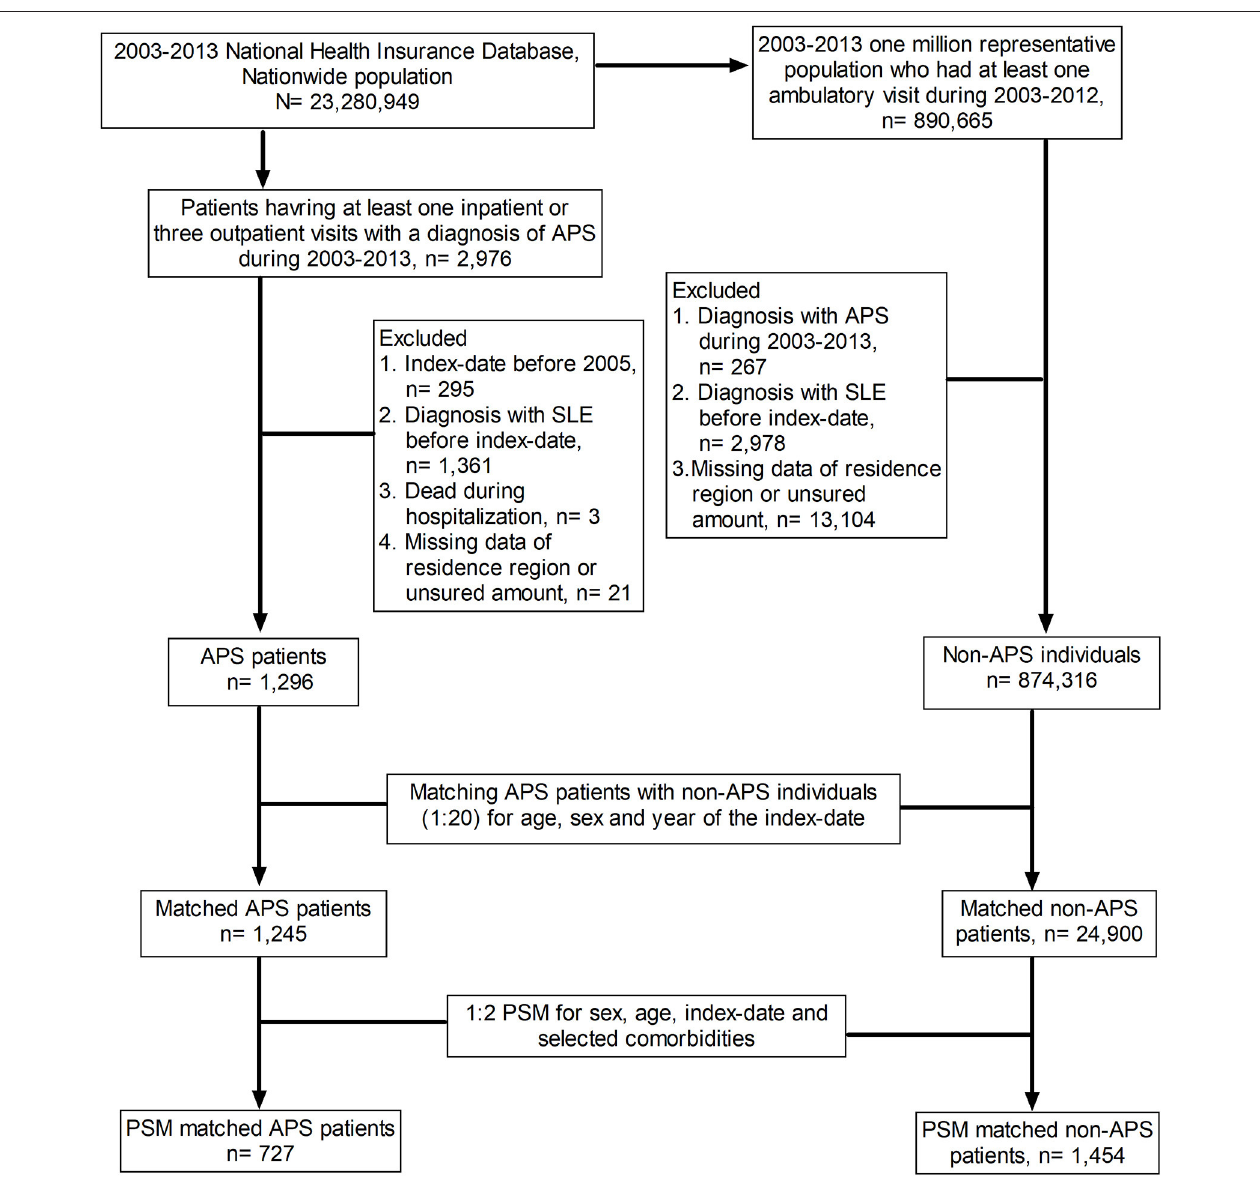
FIGURE 1 | Flow chart of the study design. APS, anti-phospholipid syndrome; SLE, systemic lupus erythematosus; PSM, propensity score